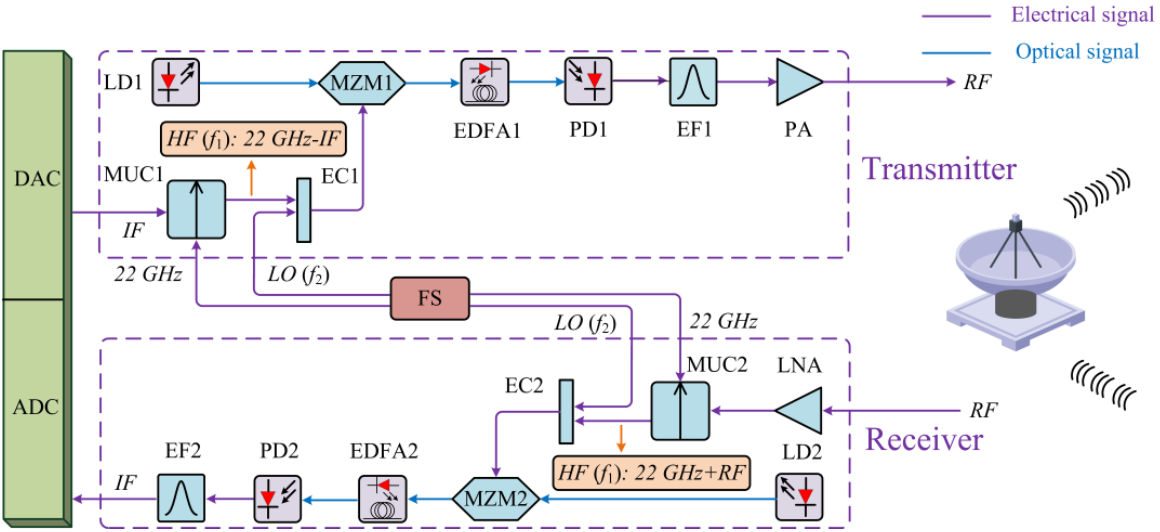
Figure 1. Schematic diagram of the transceiver using proposed microwave photonic converter (the meanings of the abbreviations in the figure are shown in Table 1). Table 1. The meaning of the abbreviations in Figure 1.